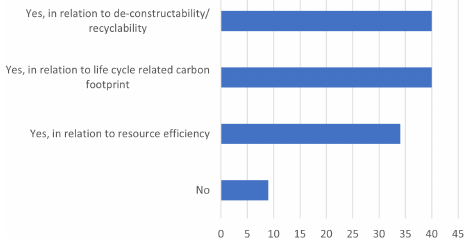
Figure 10. Responses to the question: From your point of view, should life cycle-related requirements in the area of environmental performance be de- fined/introduced into building codes and laws in fu- ture, if not already the case? (based on 61 respondents, more than one answer could be selected).